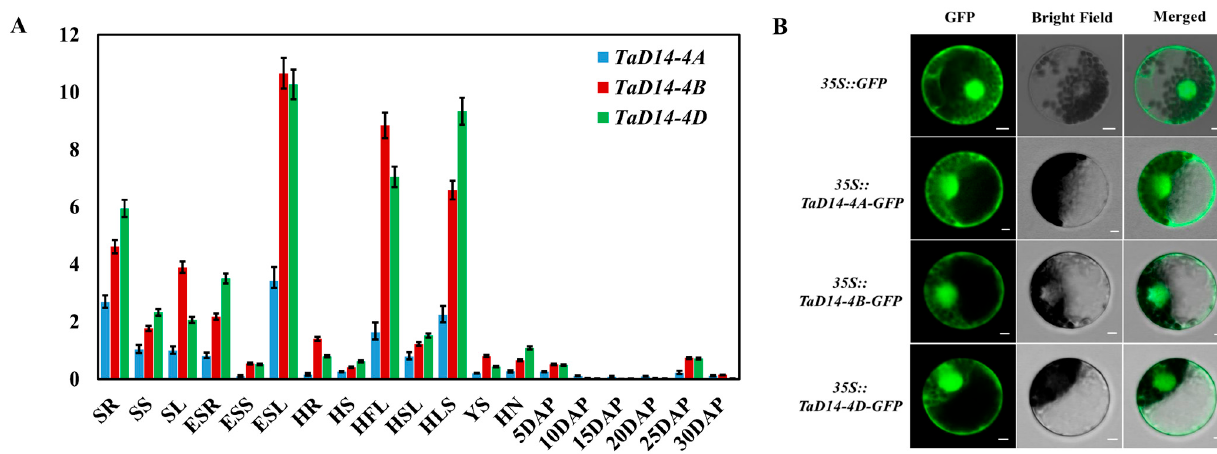
Figure 3. Expression analyses of TaD14 genes and subcellular localization of TaD14 proteins. ( A ) Tissue-specific expression pattern of TaD14 genes in different tissues and growth periods of Chinese Spring. SR, seedling roots; SS, seedling stems; SL, seedling leaves; ESR, roots at elongation stage; ESS, stems at elongation stage; ESL, leaves at elongation stage; HR, roots at heading stage; HS, stems at heading stage; HFL, flag leaves at heading stage; HSL, top second leaves at heading stage; HLS, leaf sheaths at heading stage; YS, young spikes; HN, nodes at heading stage; DAP, days after pollination, grains at different developmental stages, namely 5, 10, 15, 20, 25, and 30 DAP. The normalized value of TaD14 gene expression relative to TaActin is derived from the mean ± SD of three technical repeated experiments. ( B ) Subcellular localization of TaD14 proteins in wheat leaf protoplasts. The free GFP and TaD14–GFP fusions under the control of the cauliflower mosaic virus 35S promoter were transiently expressed in wheat leaf protoplasts. The fluorescence signal of GFP was observed under a confocal laser scanning microscope after transfection for 16 h. Scale bars, 10 μ m.